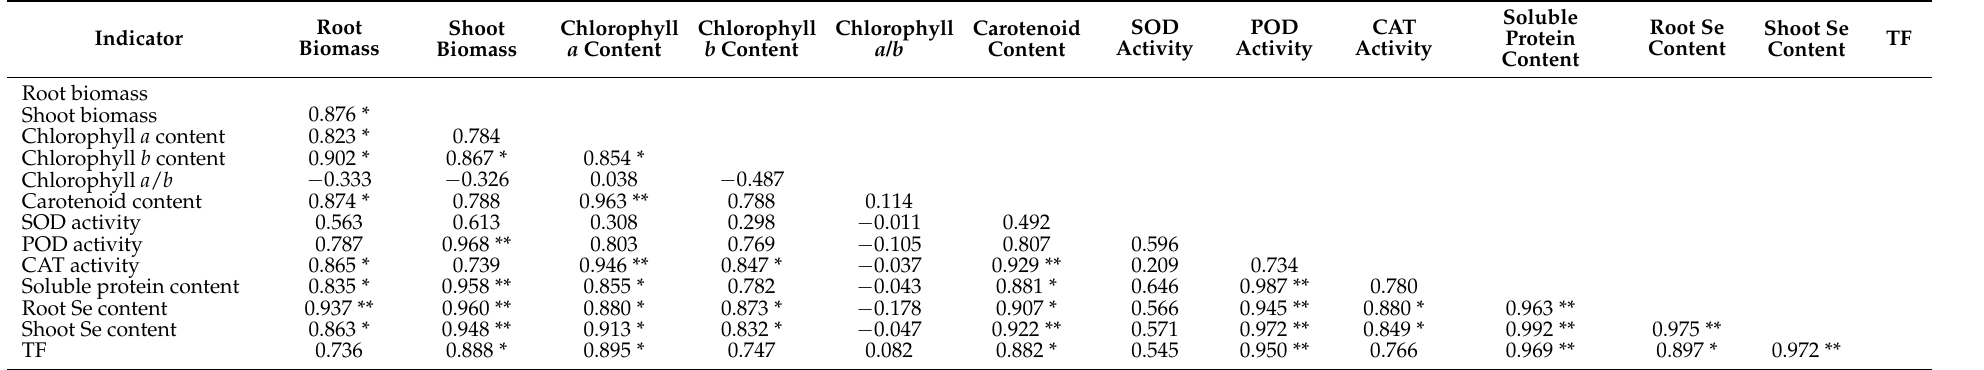
Table 5. Correlations among the different indicators of tetraploid.